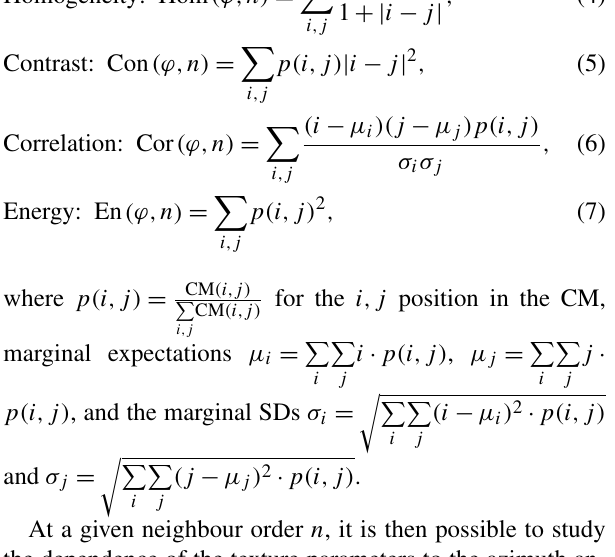
Table 4. Co-occurrence matrix after the image pre-processing (Fig. 6b) for the third neighbour (n = 3 ) and for the transverse di- rection in the clockwise direction (azimuth ϕ = + 90 ◦